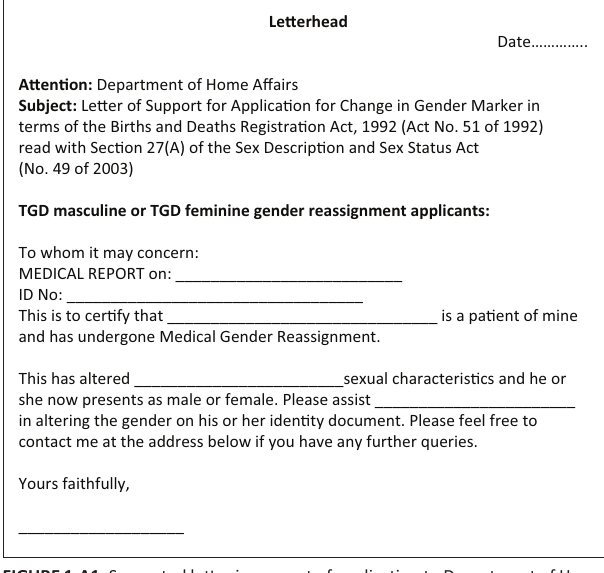
Le(cid:29)erhead